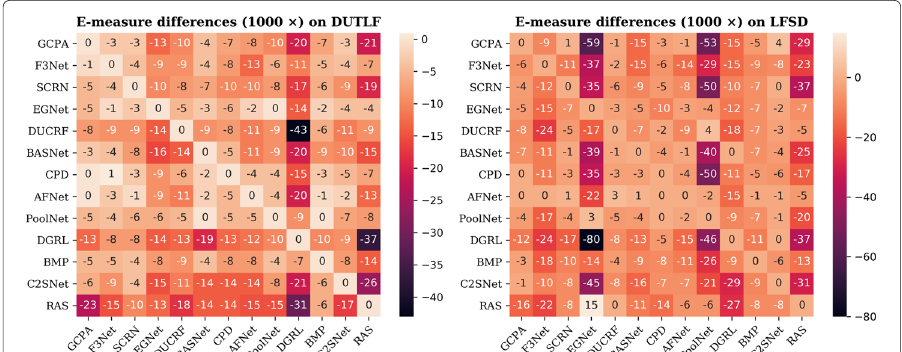
Fig. 7 Generalization analysis of the proposed method. We evaluate the model trained by the saliency results of one 2D method (denoted on each row) on other 2D ones (denoted on each column). Each entry in the confusion matrix denotes the E -measure difference with the method trained on its own saliency maps. We expand the differences by 1000 times for better